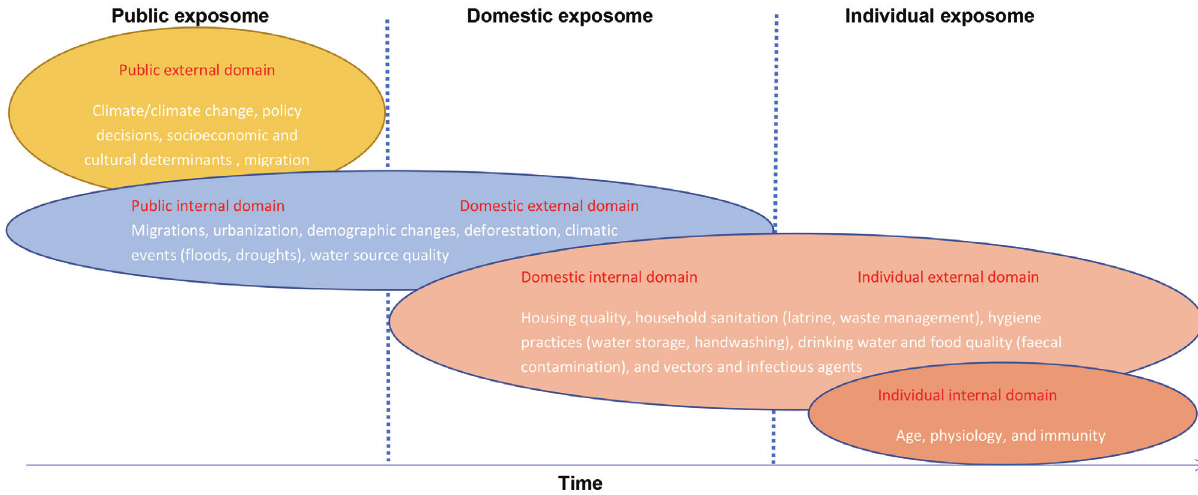
Figure 1. Urban exposomes for waterborne diseases in sub-Saharan